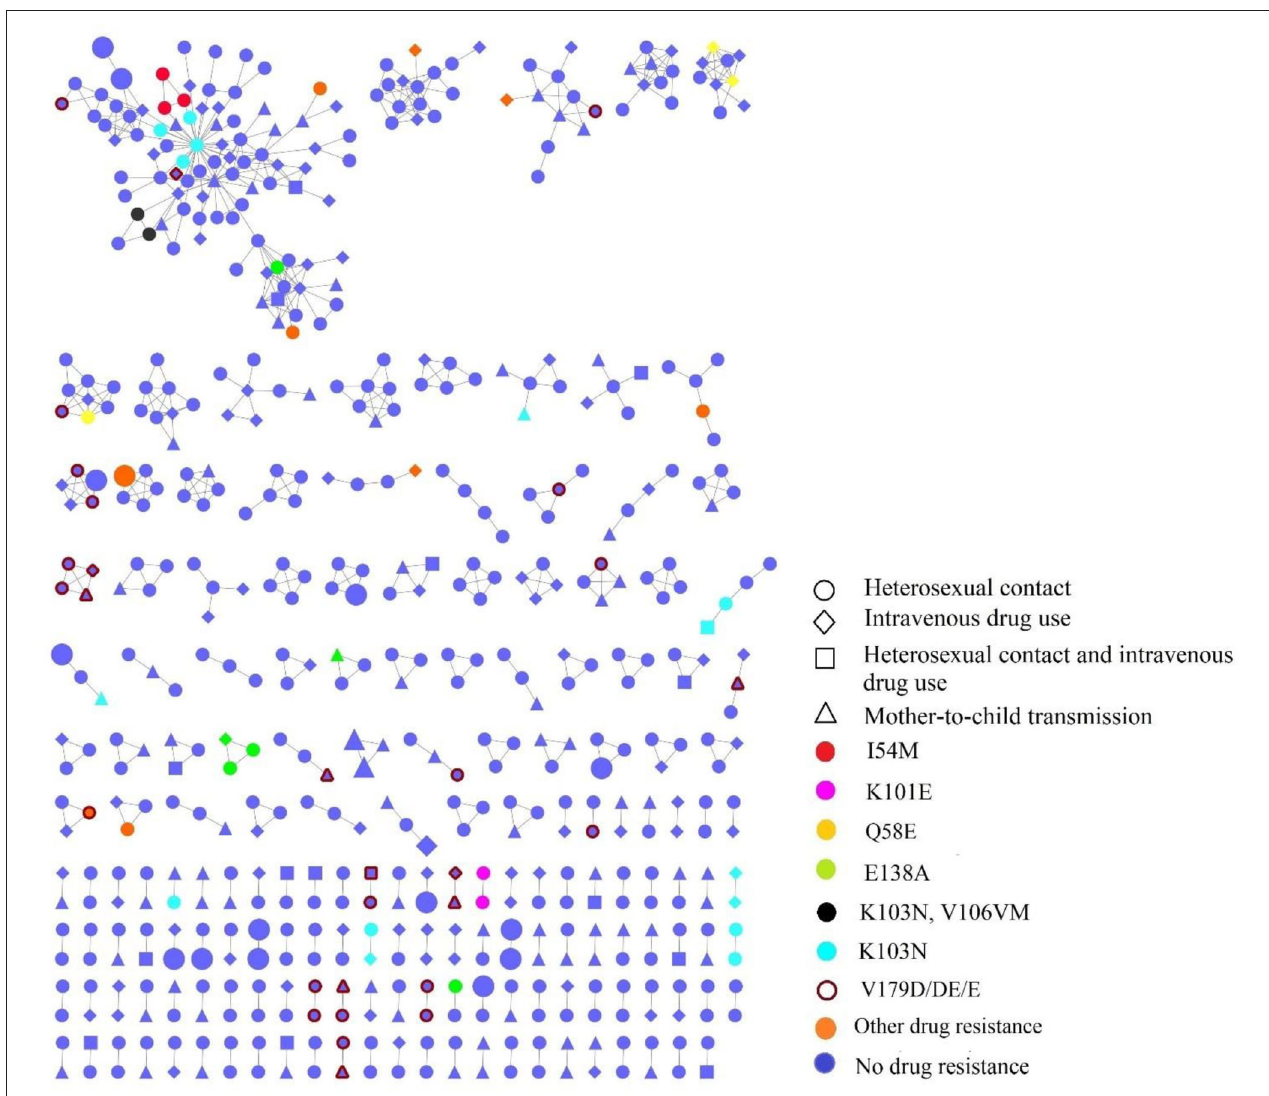
FIGURE 3 | The transmission networks of HIV-1 newly diagnosed people living with HIV (PLWH) by HIV transmission routes and TDR mutations; the large shapes represented recent infections within 130 days by LAg EIA.